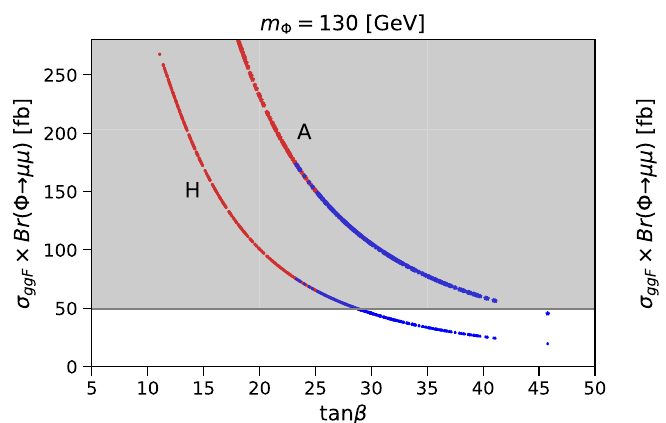
gray region is ruled out by the CMS search [36]. For red (blue) points, θ 23 resides in the first (second)